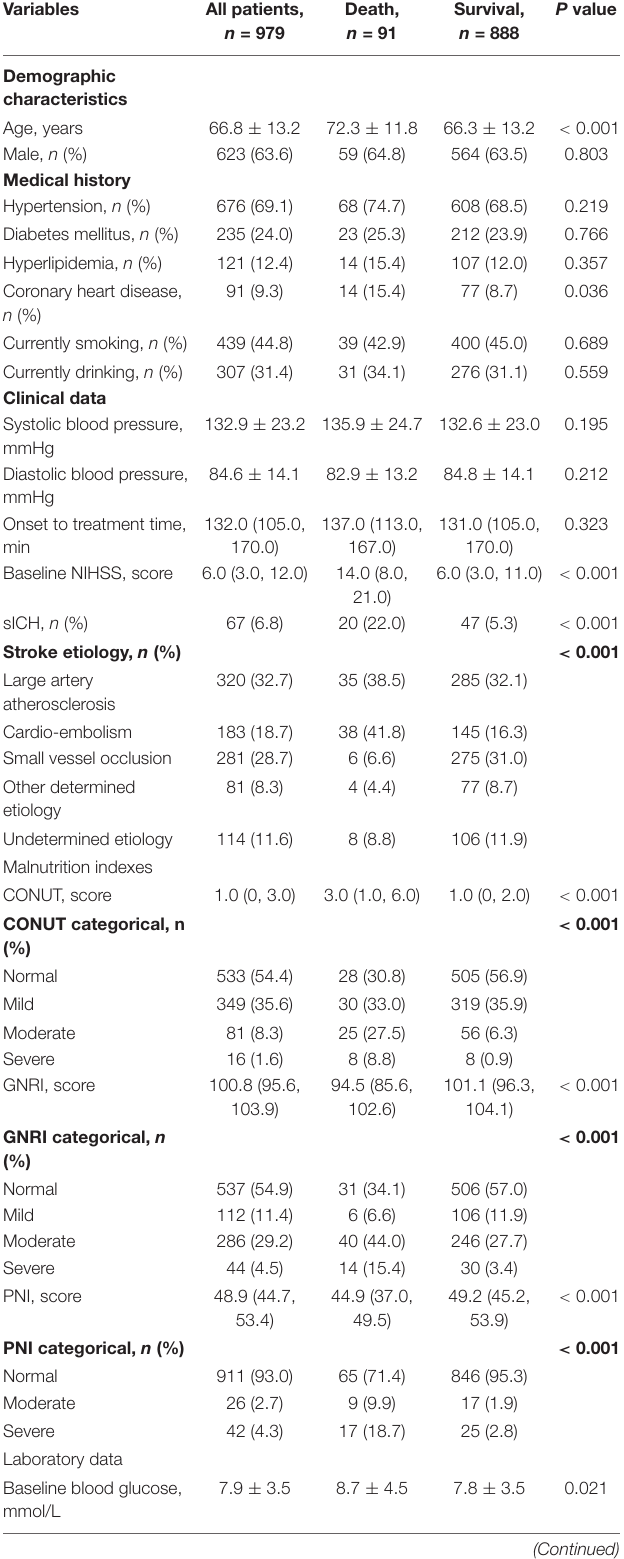
TABLE 1 | Demographics and baseline characteristics stratified by clinical outcome.